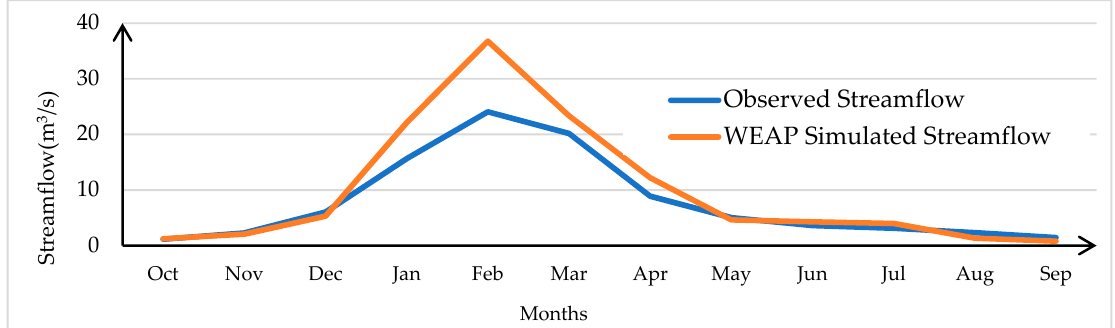
Figure 11. Comparison of observed and simulated mean monthly streamflow at Chongwe Great East Road Bridge (Station 5-025) for the period 1982/83 to 2016/17 .